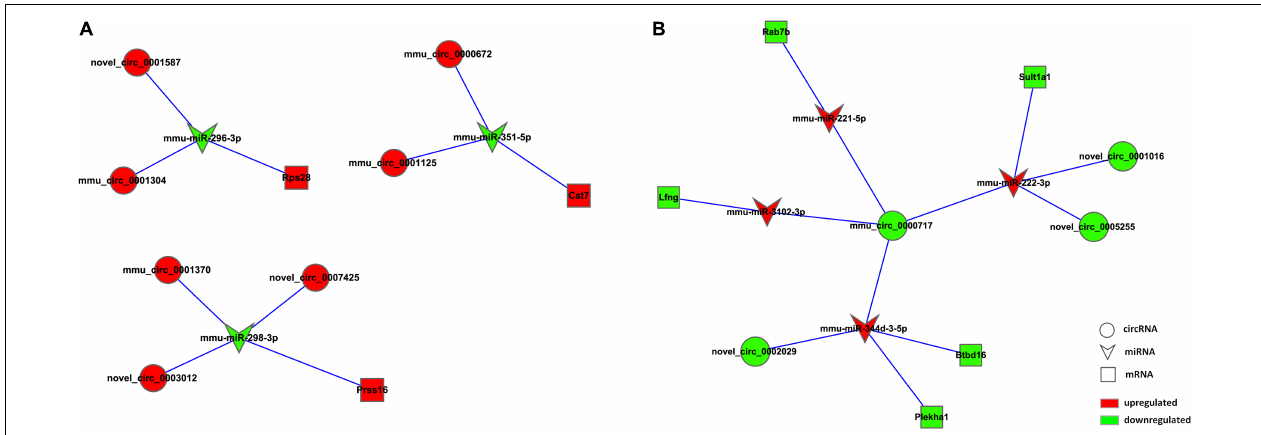
FIGURE 4 | CircRNA-ceRNA network analysis in hippocampal tissue of APP/PS1 Mice. The ceRNA networks were based on circRNA-miRNA and miRNA-mRNA interactions. Circle nodes represent circRNAs, triangle nodes represent miRNAs, and rectangle nodes represent mRNAs. Red represent upregulated, green represent downregulated. (A) circRNA (down in APP/PS1 mice)-miRNA (up in APP/PS1 mice)-mRNA (down in APP/PS1 mice). (B) circRNA (up in APP/PS1 mice)-miRNA (down in APP/PS1 mice)-mRNA (up in APP/PS1